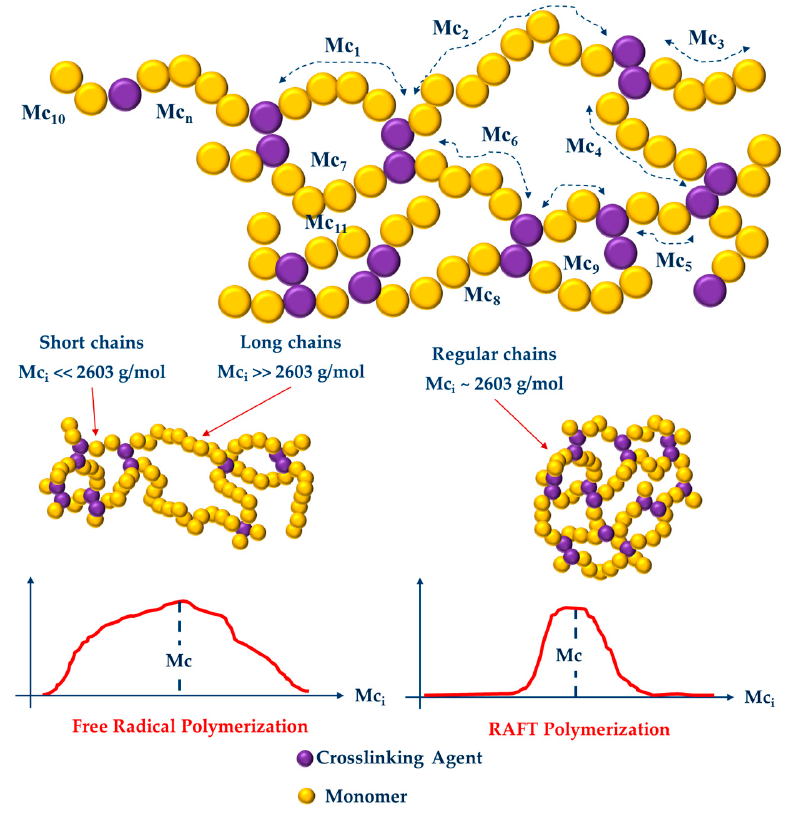
Figure 5. Schematic representation of the Mc distribution in polymer networks and how they differ for hydrogels synthesized by FRP and RAFT copolymerizations. Table 3. Estimation of average molecular weight between crosslinks from the Flory–Rehner equation. Polymerization